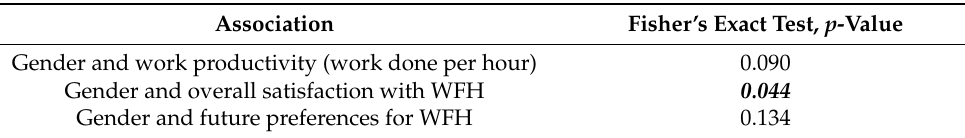
Table 6. Associations between gender and self-reported work productivity, overall WFH satisfaction and future preference for WFH.